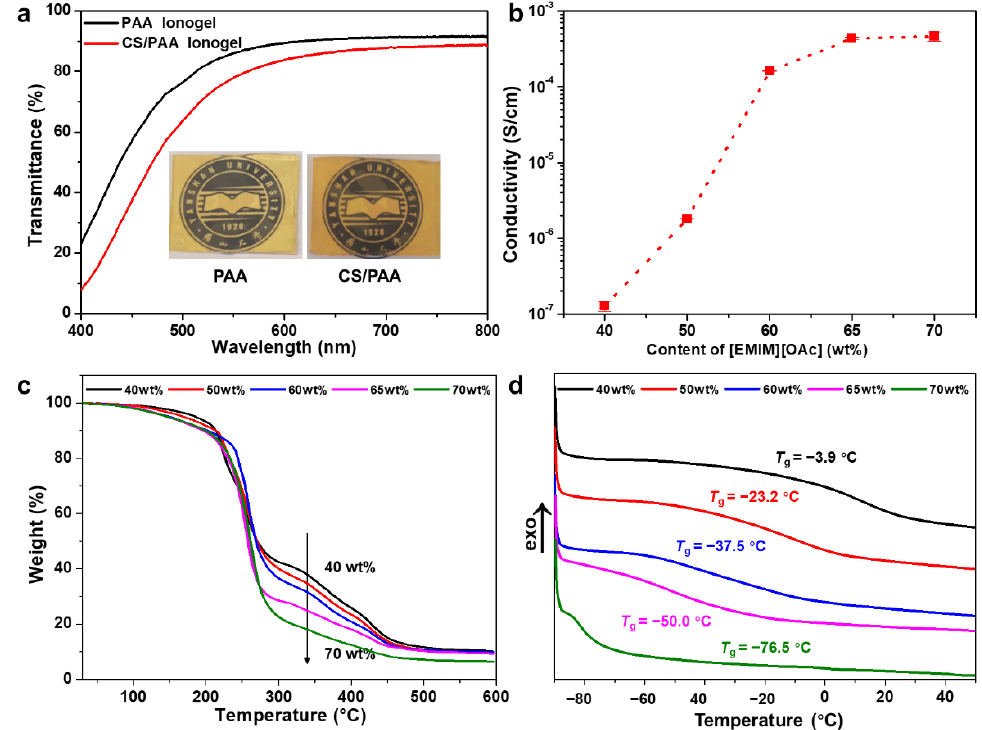
Figure 2. Transmittance of PAA and CS/PAA DN ionogels ( a ), conductivity ( b ), TGA ( c ) and DSC curves ( d ) of the ionogels with different contents of ionic liquid.